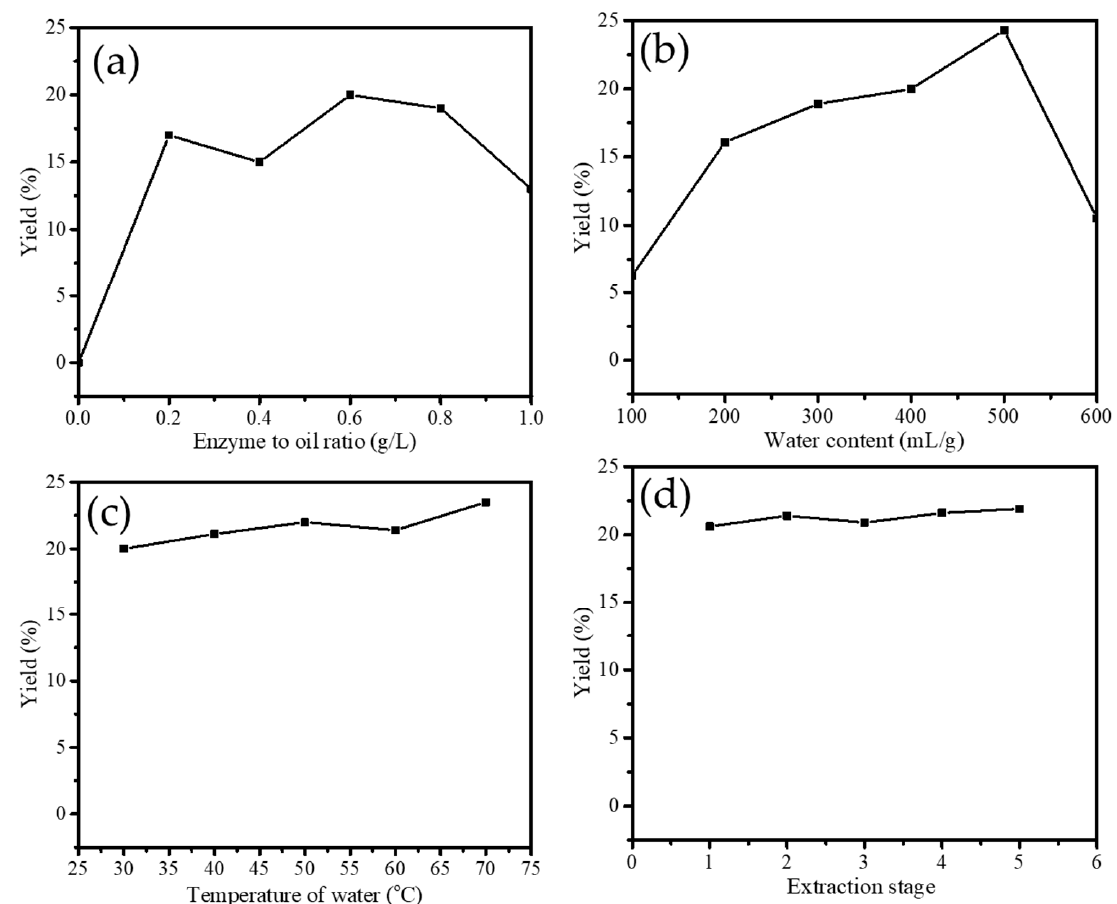
Figure 2. ( a ). Effect of enzyme on yield of VCO extraction ( b ). Effect of water content on yield of VCO extraction ( c ). Effect of temperature of water on yield of VCO extraction ( d ). Effect of extraction stage on yield of VCO extraction.